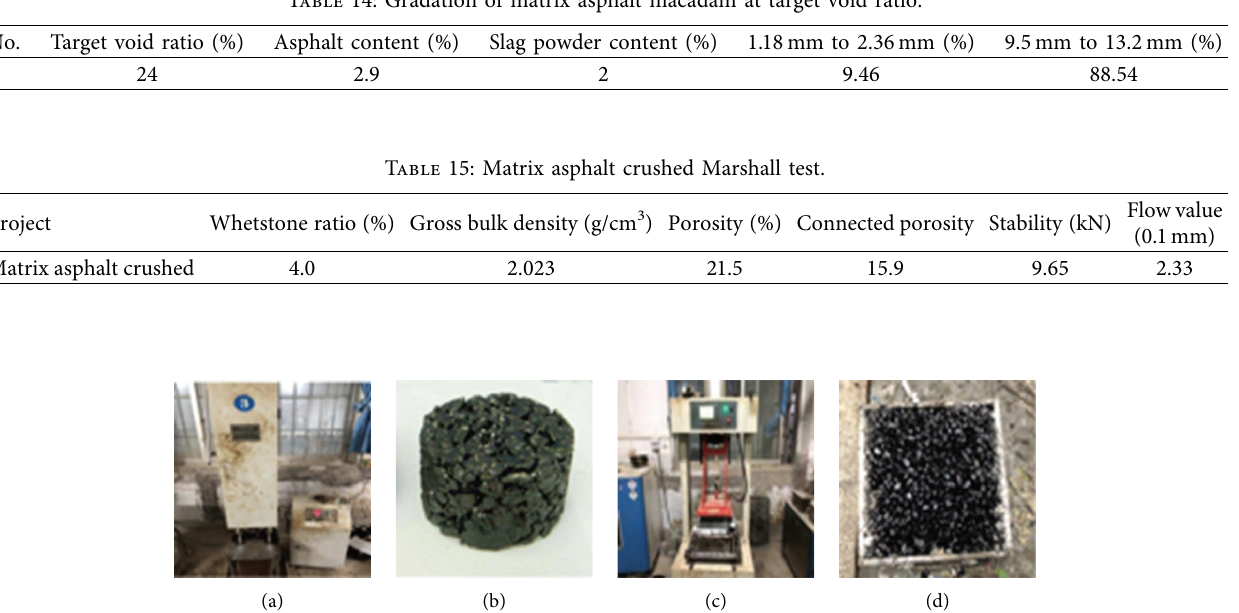
Table 14: Gradation of matrix asphalt macadam at target void ratio.